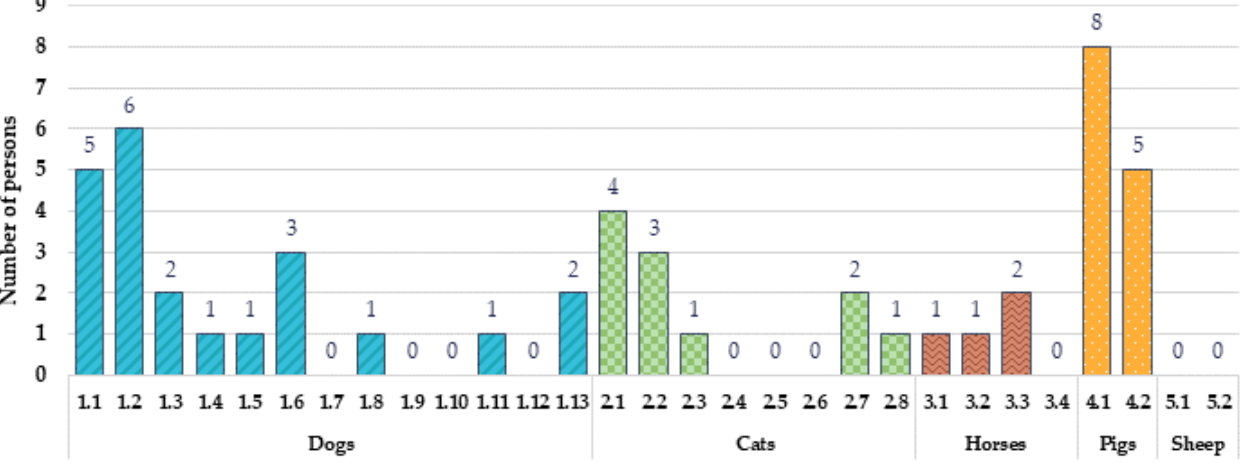
Figure 4. Number of participants with the maximum emotion ‘happy’ induced by different animal species and breeds (dogs: 1.1. Australian shepherd, 1.2. pug, 1.3. Labrador retriever, 1.4. Doberman, 1.5. miniature schnauzer, 1.6. beagle, 1.7. mixed breed, 1.8. Yorkshire terrier, 1.9. mixed breed, 1.10. mixed breed, 1.11. Cane Corso, 1.12. Samoyed, and 1.13. Chihuahua; cats: 2.1. mixed breed, 2.2. British shorthair, 2.3. Himalayan cat, 2.4. mixed breed, 2.5. mixed breed, 2.6. Siamese cat, 2.7. Sphynx, and 2.8. Bengal cat; horses: 3.1. Norwegian Fjord, 3.2. Exmoor pony, 3.3. Andalusian, and 3.4. Friesian; pigs: 4.1. Vietnamese pot-bellied and 4.2. Kunekune; sheep: 5.1. Herdwick sheep and 5.2. Suffolk sheep).